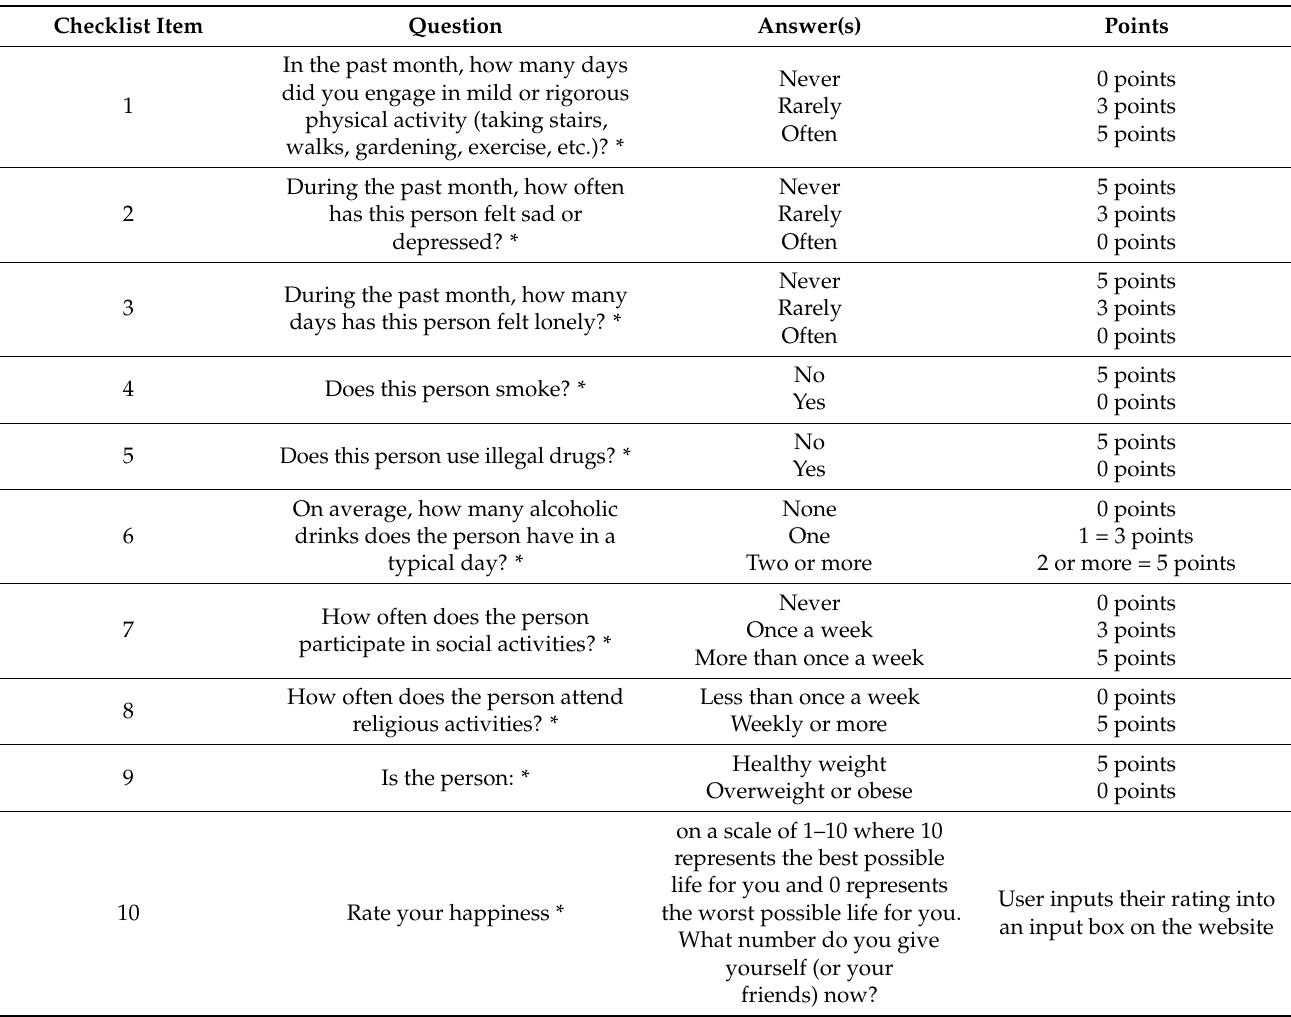
Table 7. Questions the “Tribe” checklist asks individuals